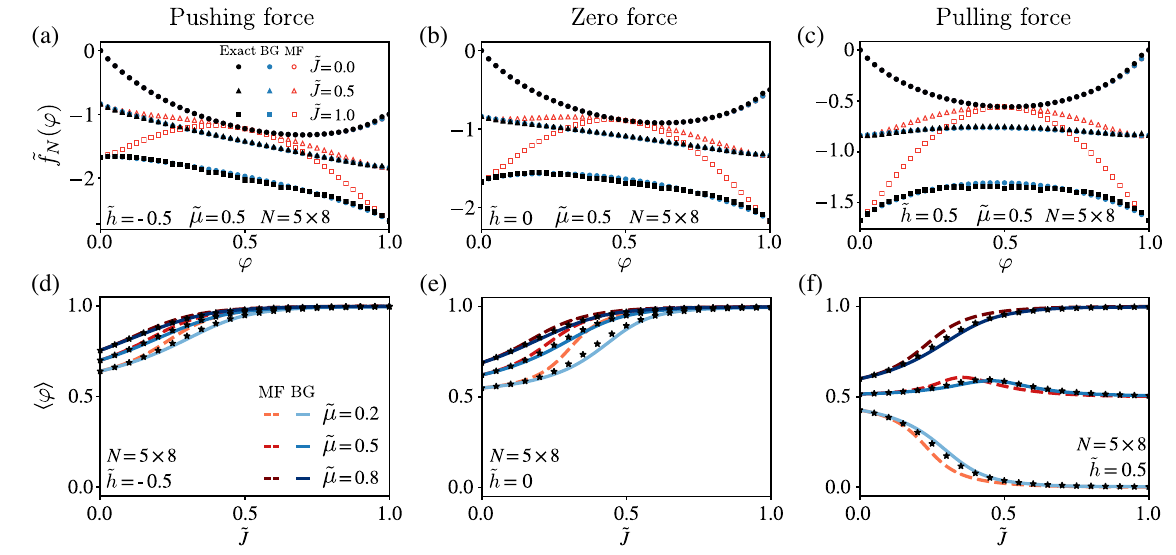
˜ φ Þ from f N ð ˜ ˜ h ¼ − 0 . 5 , (e) no force h ¼ 0 , and (f) pulling force ˜ J for ˜ h ¼ 0 . 5 . Symbols depict exact results, blue lines correspond to the